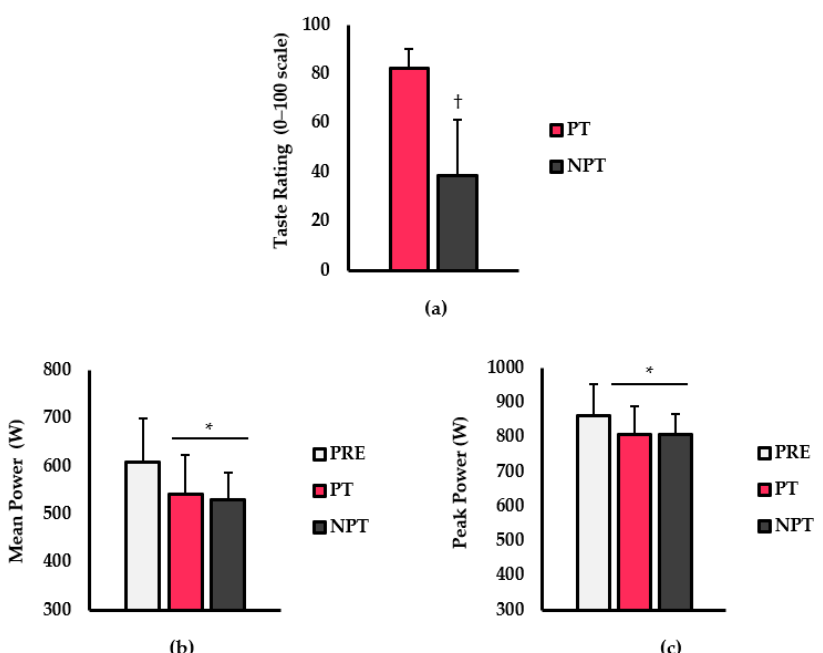
Figure 1. Differences in ( a ) Taste rating (0–100 scale), ( b ) Mean power (watts ; W), and ( c ) Peak power (watts; W) between pre-taste (PRE; light grey bars), preferred taste (PT; pink), and non-preferred taste (NPT; dark grey) conditions. Data are presented as mean ± SD. † indicates significantly different from PT ( p < 0.05). * indicates significantly different from PRE ( p < 0.05).